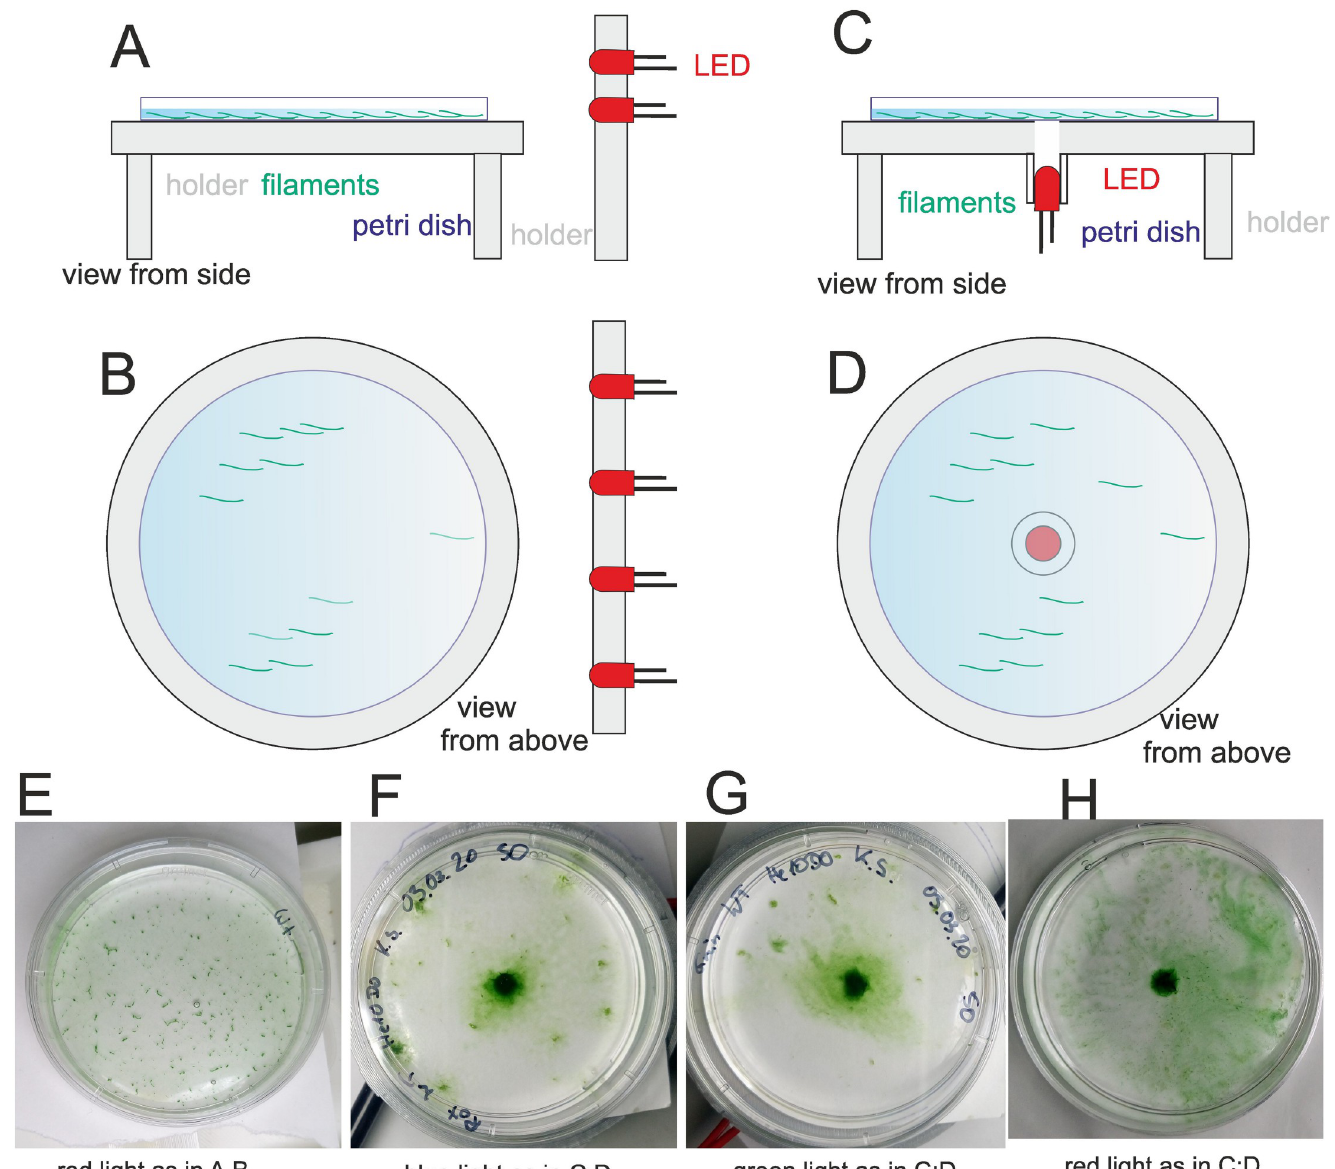
Fig 4. Setup of phototaxis experiments with unilateral irradiation (from the side, A, B) or vertical irradiation (C, D) and examples for irradiations with red light from the side (E) or vertical blue (F), green (G) or red light (H) from below. Light intensities were 25 μ mol m -2 s -1 for blue (450 nm) and green (550 nm) and 15 μ mol m -2 s -1 for red (655 nm) light. The duration of irradiation was 2